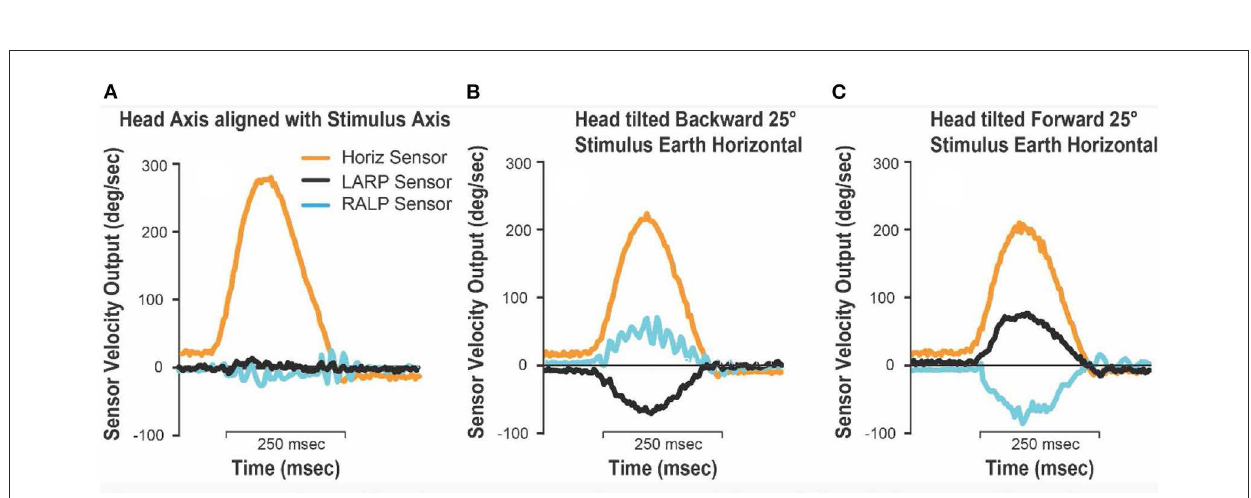
FIGURE9 Goggles 3-D head sensor outputs for test jig leftwards earth-horizontal impulses. (A) Stimulus axis and head axis aligned (upright, forwards and backwards); (B) head tilted 25 ◦ backward, jig impulse earth horizontal; (C) head tilted 25 ◦ forwards, jig impulse earth horizontal. Note that when the head is tilted forward or backwards, and the stimuli are delivered in the earth horizontal plane, the horizontal head velocity sensor underestimates the true horizontal head rotation velocity by the cosine of the misalignment angle. In this case it will be underestimated by about 10% (cos 25 ◦ =